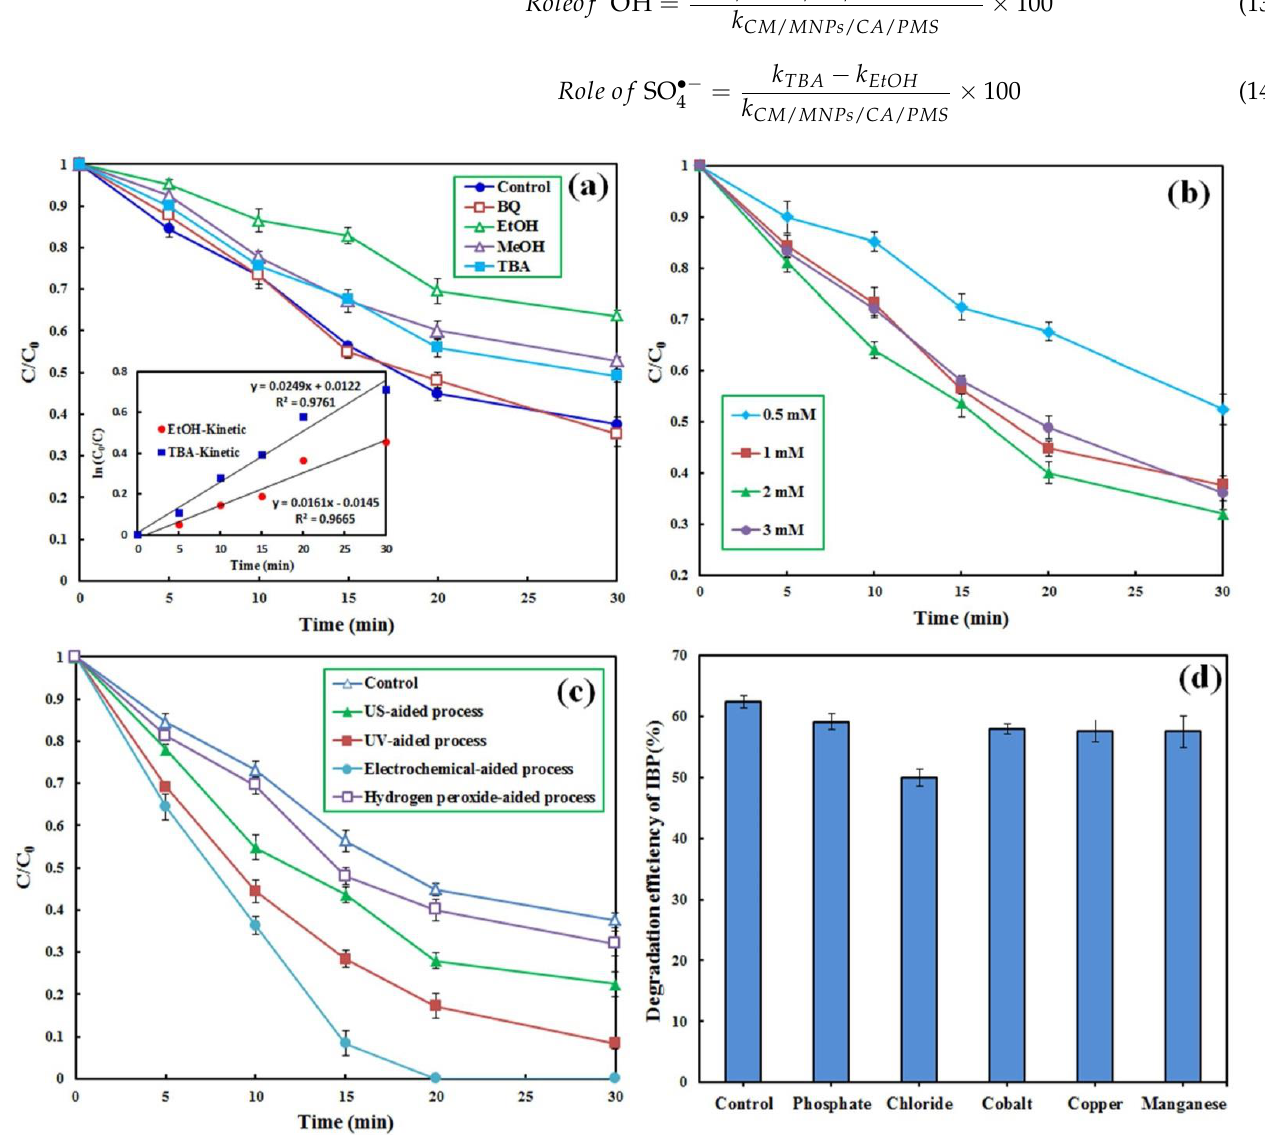
Figure 5. Effect of scavenging compounds ( a ), PMS concentration ( b ), enhancers ( c ) and presence of co-compounds ( d ) on the degradation of IBP by the CM/MNPs/CA/PMS process. Experimental conditions: [IBP] 0 : 25 µ M, catalyst dosage: 0.3 g/L, reaction time: 30 min, [scavengers] 0 : 0.1 M, [H 2 O 2 ] 0 : 50 mM, current intensity: 100 mA, [co – compounds] 0 : 0.01 M.